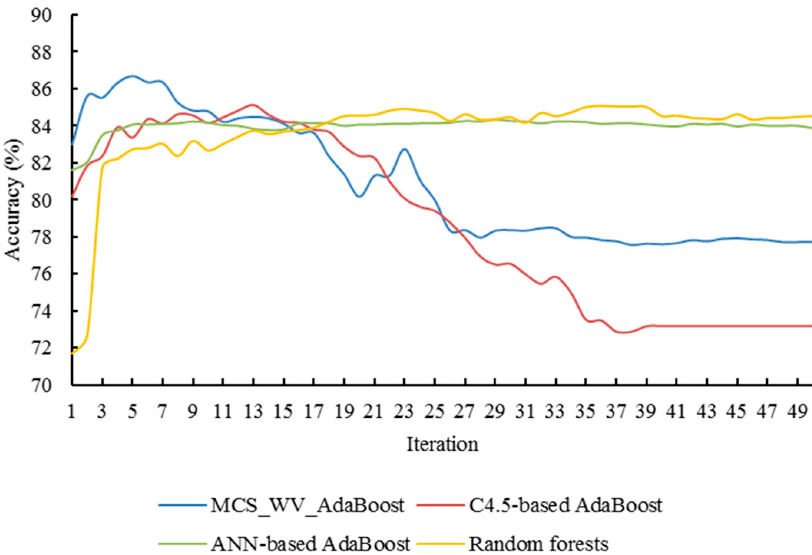
Figure 9. Classification accuracy improvements of MCS_WV_AdaBoost using two base classifier training algorithms: C4.5 and ANN.